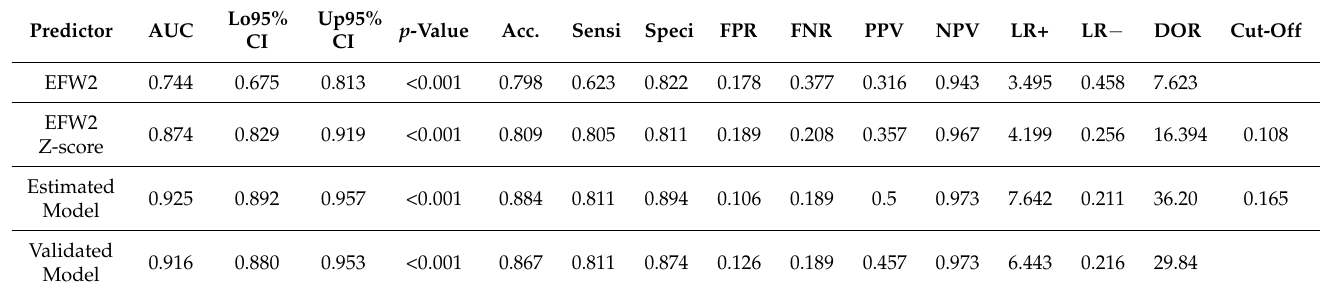
Table 4. Diagnostic performance of EFW2, estimated model, and validated model using type (LGA vs. AGA).